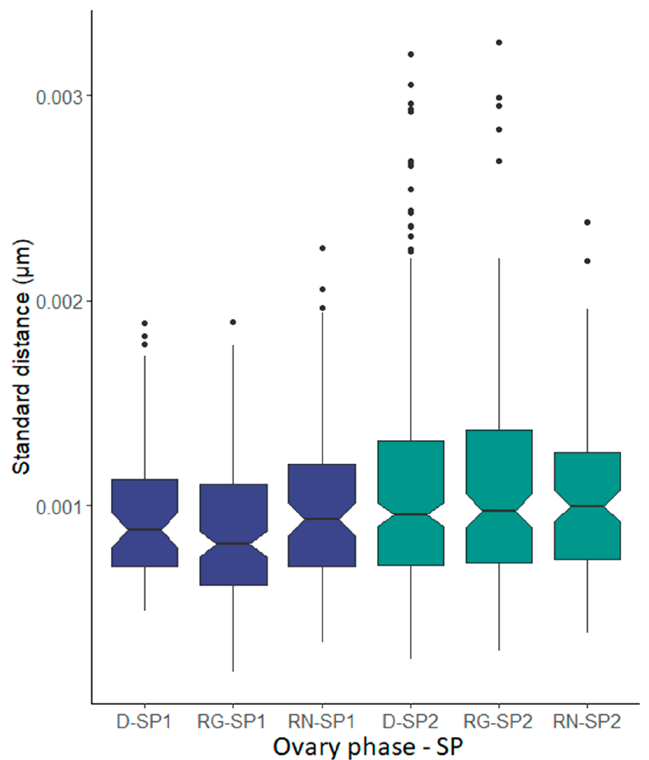
Figure 4. Standard distances (µm) of daily increments in the last 15 days before capture in European hake females captured in 2017 by ovarian development phase (D: developing, RG: regressing, RN: regenerating) and spawning peak (SP1, SP2). The box represents the interquartile range (25th to the 75th percentile), the line in the box represents the mean value, the solid vertical lines represents the standard error, and the notch is the 95% confidence interval of the median.